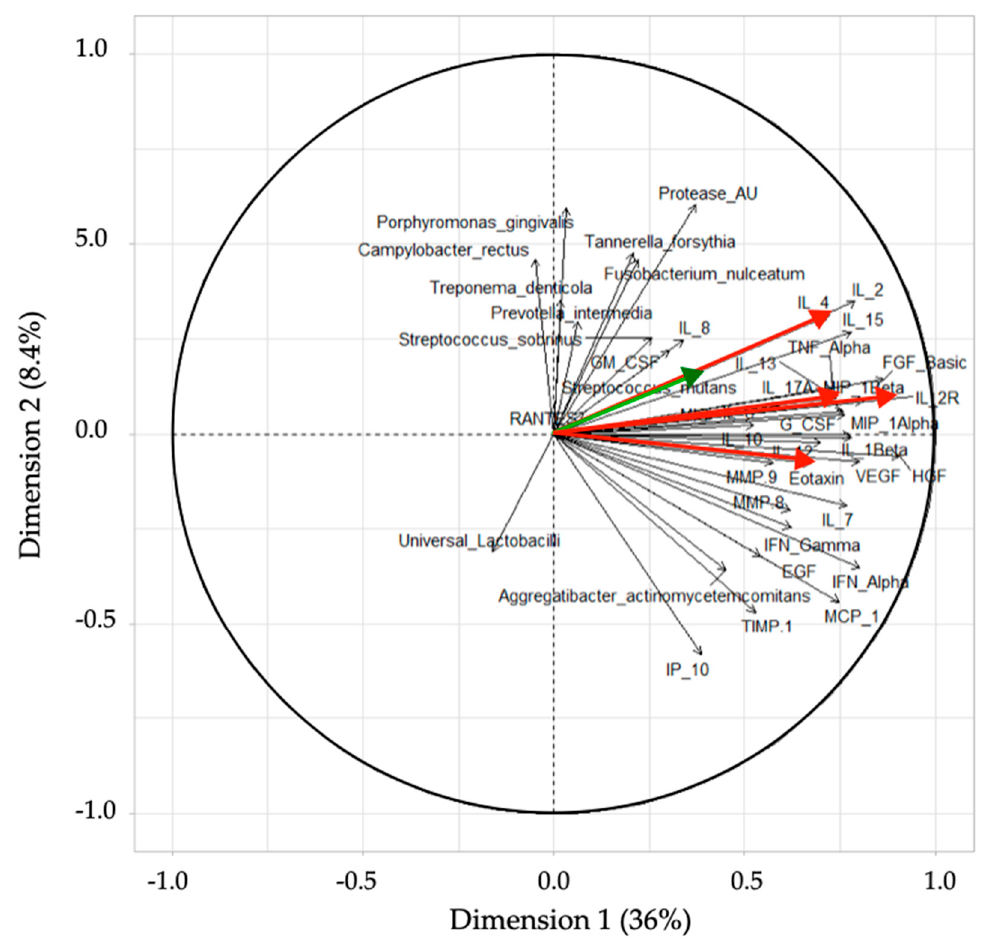
Figure 6. PCA loading plot visualizing the correlation between the biomarkers tested and clusters of samples, grouped based on their similarity. The red-colored arrows show the four biomarkers (ordered from top to bottom): IL-4, IL-13, IL-2-RA, and eotaxin/CCL11. The S. mutans arrow is colored in green, in close proximity to IL-4.